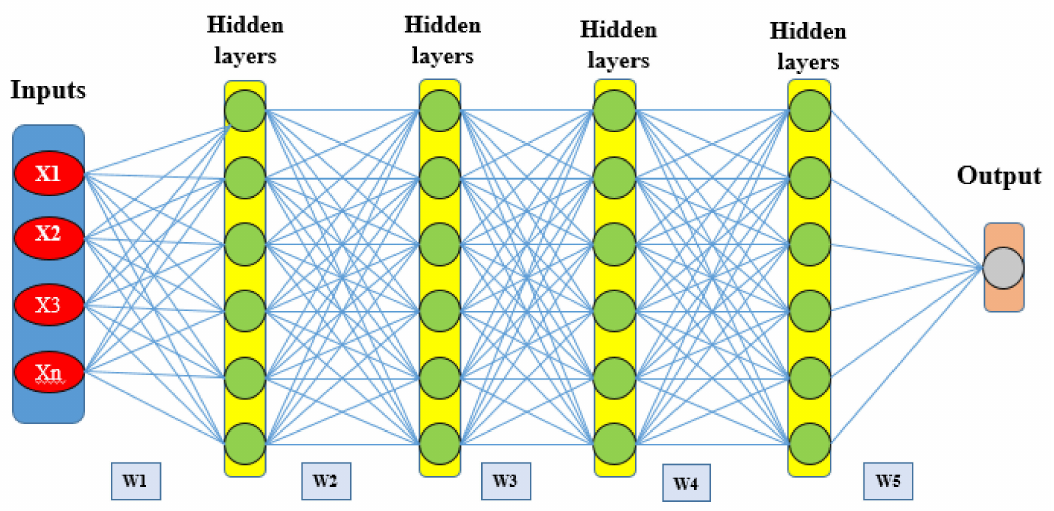
Figure 6. Schematic of deep learning neural